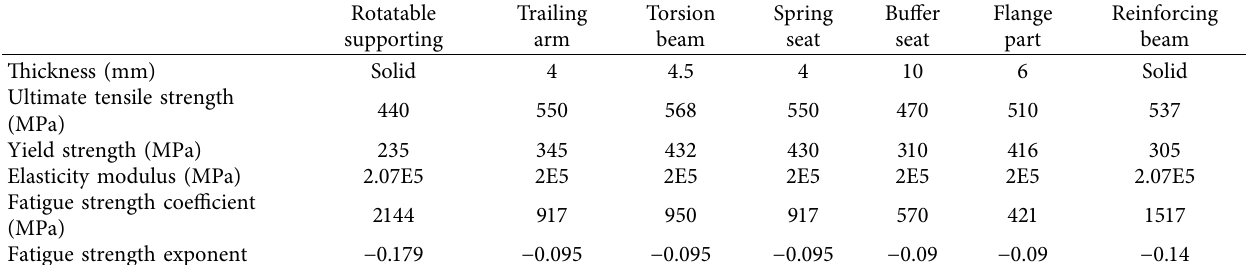
Table 1: Material properties for each part of the torsion beam suspension.